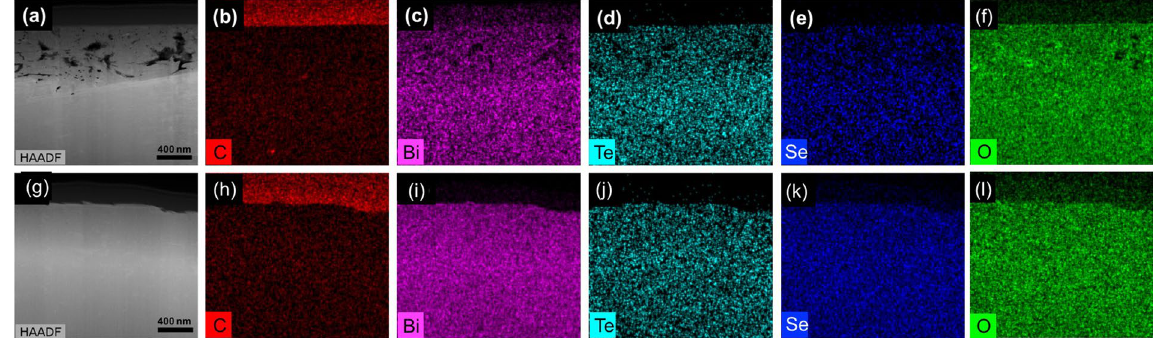
Figure 6. TEM EDS mapping images of hot pressed p-type ( a – f ) and n-type ( g – l ) with Methocel.